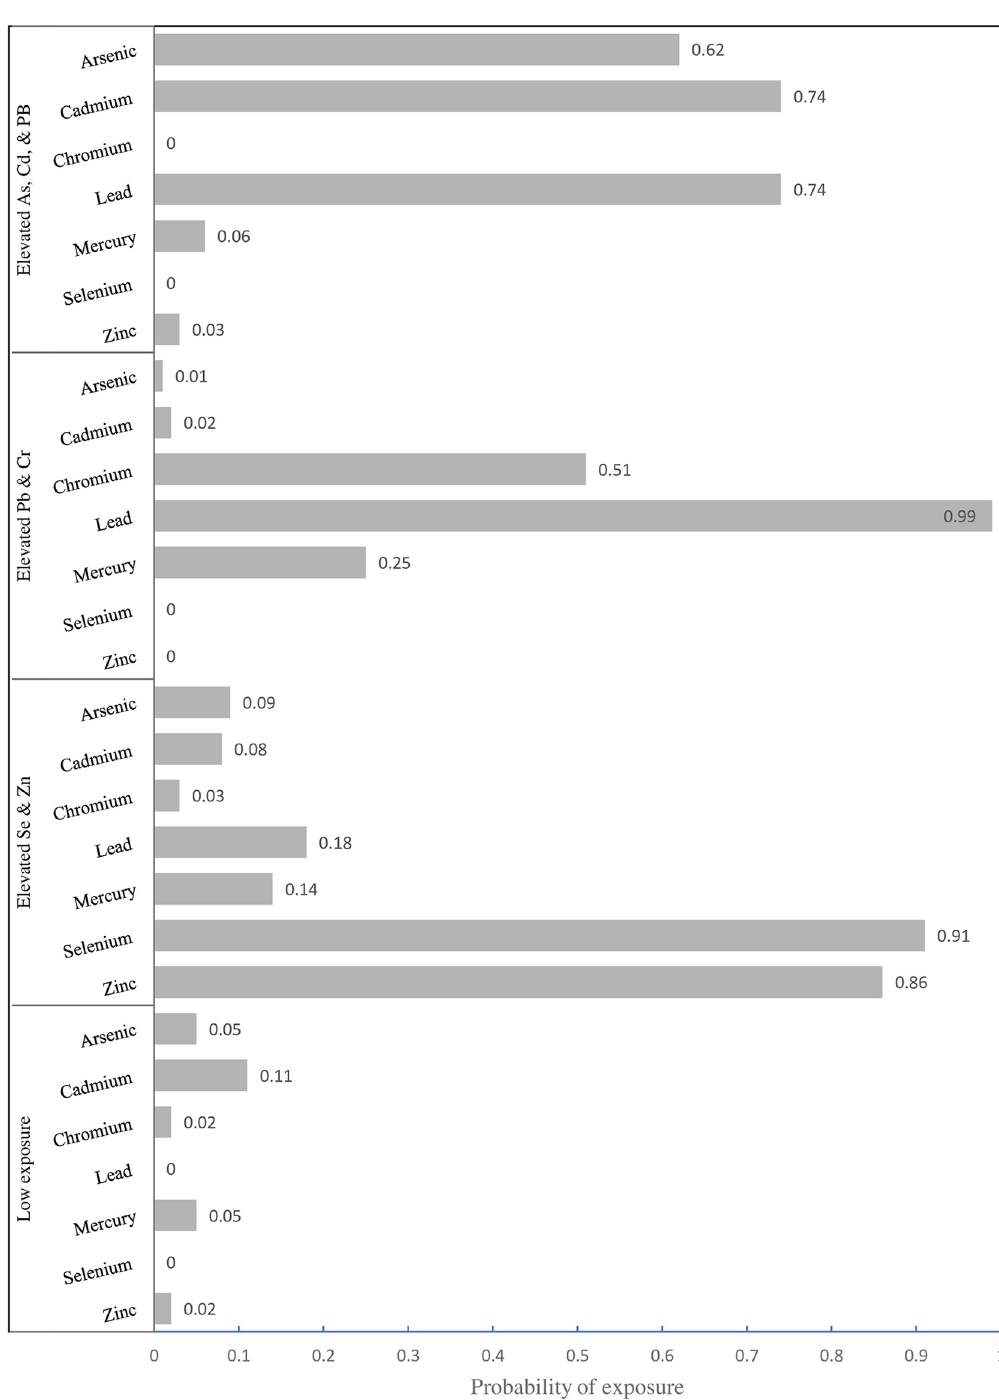
Fig 3. Class membership probabilities as a function of environmental chemical exposure.